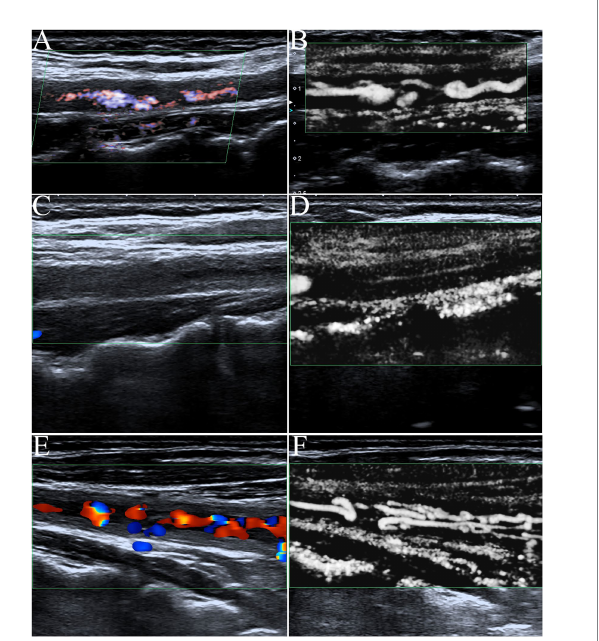
FIGURE 2 The contrast of color Doppler ultrasonography and SMI in blood flow display. (A) Advanced dramatic flow imaging showing carotid stenosis. (B) In contrast with (A) , SMI was able to clearly show low blood flow signals in the same carotid stenosis cavities. SMI improved image quality with a greater enhancement of vessel wall lumen and higher definition of the borders of the vascular lesion. (C) The affected carotid artery wall had varying degrees of diffuse thickening like macaroni signs, and color Doppler flow imaging showed occlusion of the carotid lumen. (D) In contrast with (C) , SMI could display very low blood flow signals in the lumen of the occluded carotid (fine lines) that color Doppler could not. (E) Color Doppler flow imaging showed intermittent, meandering, tortuous, and narrow blood flow signals in a fuzzy carotid lumen. (F) In contrast with (C) , SMI could clearly show the again unobstructed, meandering, tortuous, and narrow blood flow signals in the thickened vessel walls of the same carotid artery as twining